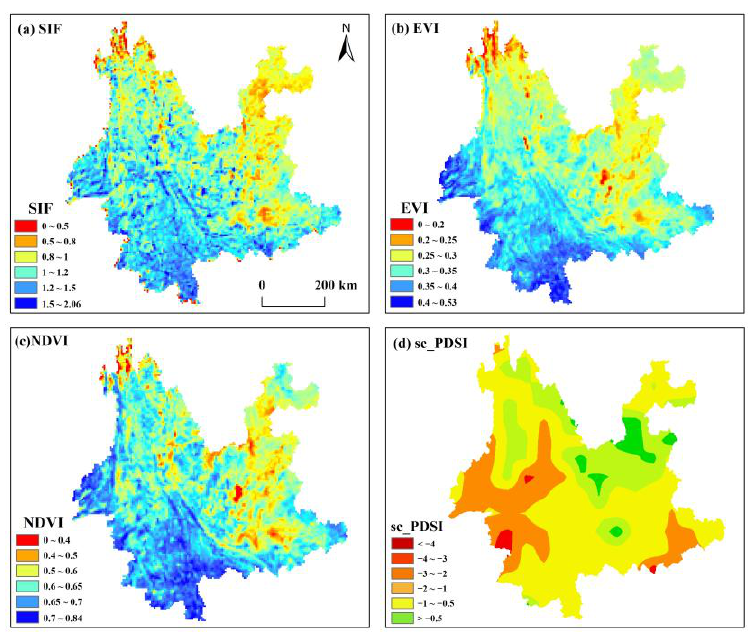
Figure 2. Distribution of monthly average values in Yunnan Province from 2009 to 2011: ( a ) SIF; ( b ) EVI; ( c ) NDVI; ( d ) sc_PDSI.